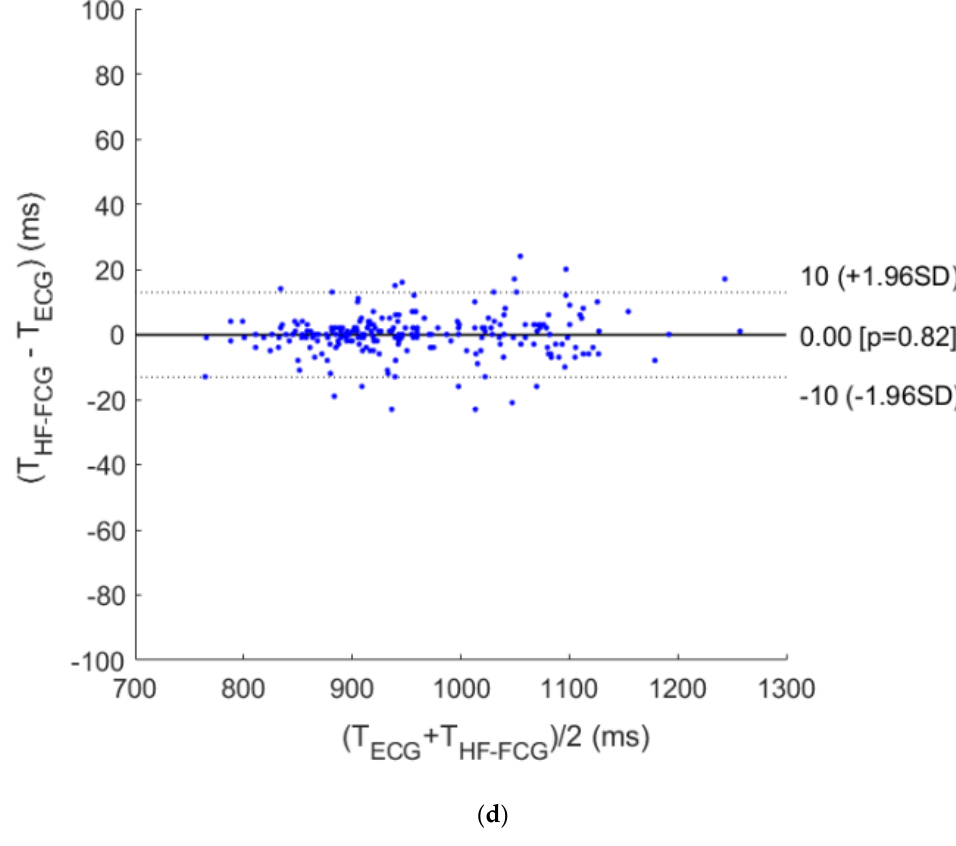
Figure 8. ( a , b ) Results of correlation and Bland–Altman analyses for inter-beat intervals estimated from ECG and LF-FCG; ( c , d ) Results of correlation and Bland–Altman analyses for inter-beat intervals estimated from ECG and HF-FCG. Bias significances were determined via one-paired t -test and the resulting p -values were reported on the plots.